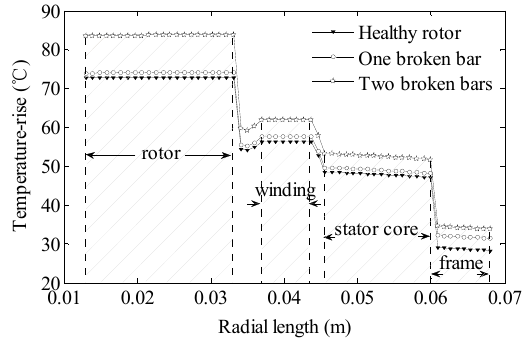
Figure 21. Temperature rise distributions of the motor along the radial direction for the three cases.